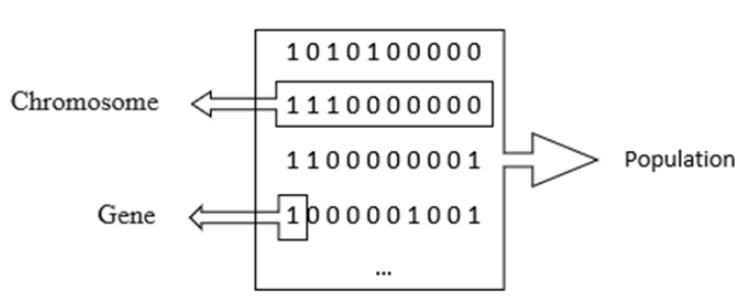
Figure 1. Gene, chromosome, and population in genetic